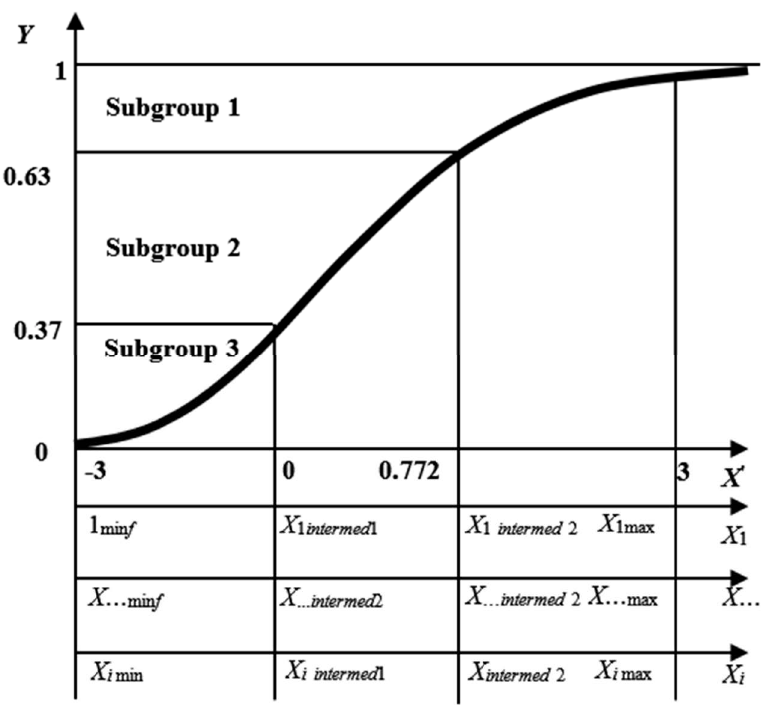
Figure 1. Graph ‐ analytical model of grouping evaluation objects into 3 subgroups Figure 1. Graph-analytical model of grouping evaluation objects into 3 subgroups (Source: compiled (Source: compiled by the author). by the